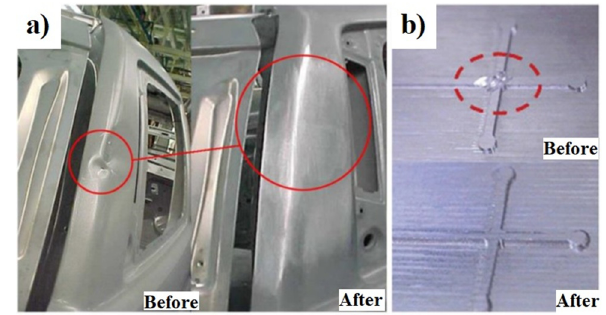
Figure 20: Repaired B737 nose wheel steering actuator barrel by CSAM [ 69 ] .